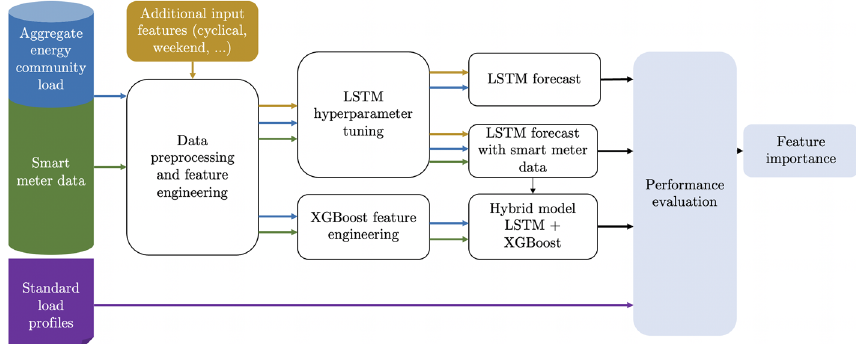
Fig. 1 Proposed research methodology framework. Arrows in different colors depict different input features for subsequent